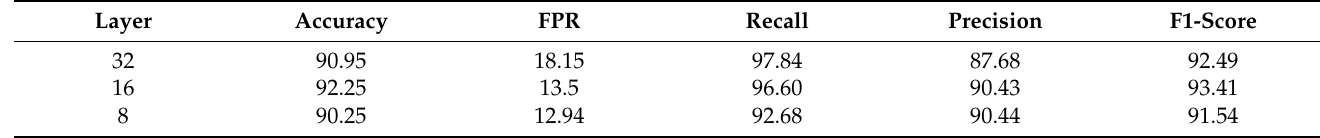
Table 6. Performance analysis on NSL-KDD for different numbers of